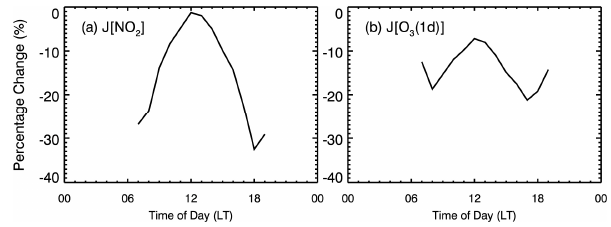
Fig. 9. Daily cycle of the percentage change of J [O 3 ( 1 D)] and J [NO 2 ] averaged over RAMA sites and during the period from 24 to 29 March 2006 when the aerosol effect on the photolysis frequencies is